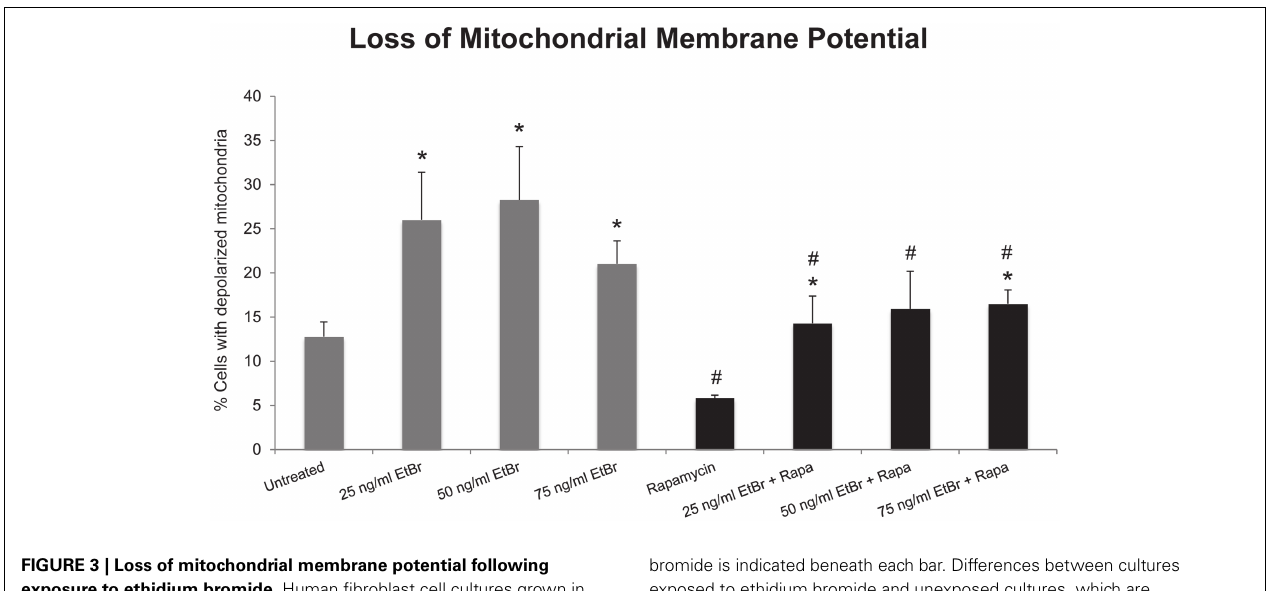
FIGURE 3 | Loss of mitochondrial membrane potential following exposure to ethidium bromide . Human fibroblast cell cultures grown in the presence or absence of 1nM rapamycin were exposed to increasing doses of ethidium bromide for a period of 7days. At this time, mitochondrial membrane potential was assessed as described in Section “Materials and Methods.” Gray bars indicate control cultures and black bars indicate rapamycin treated cultures.The concentration of ethidium